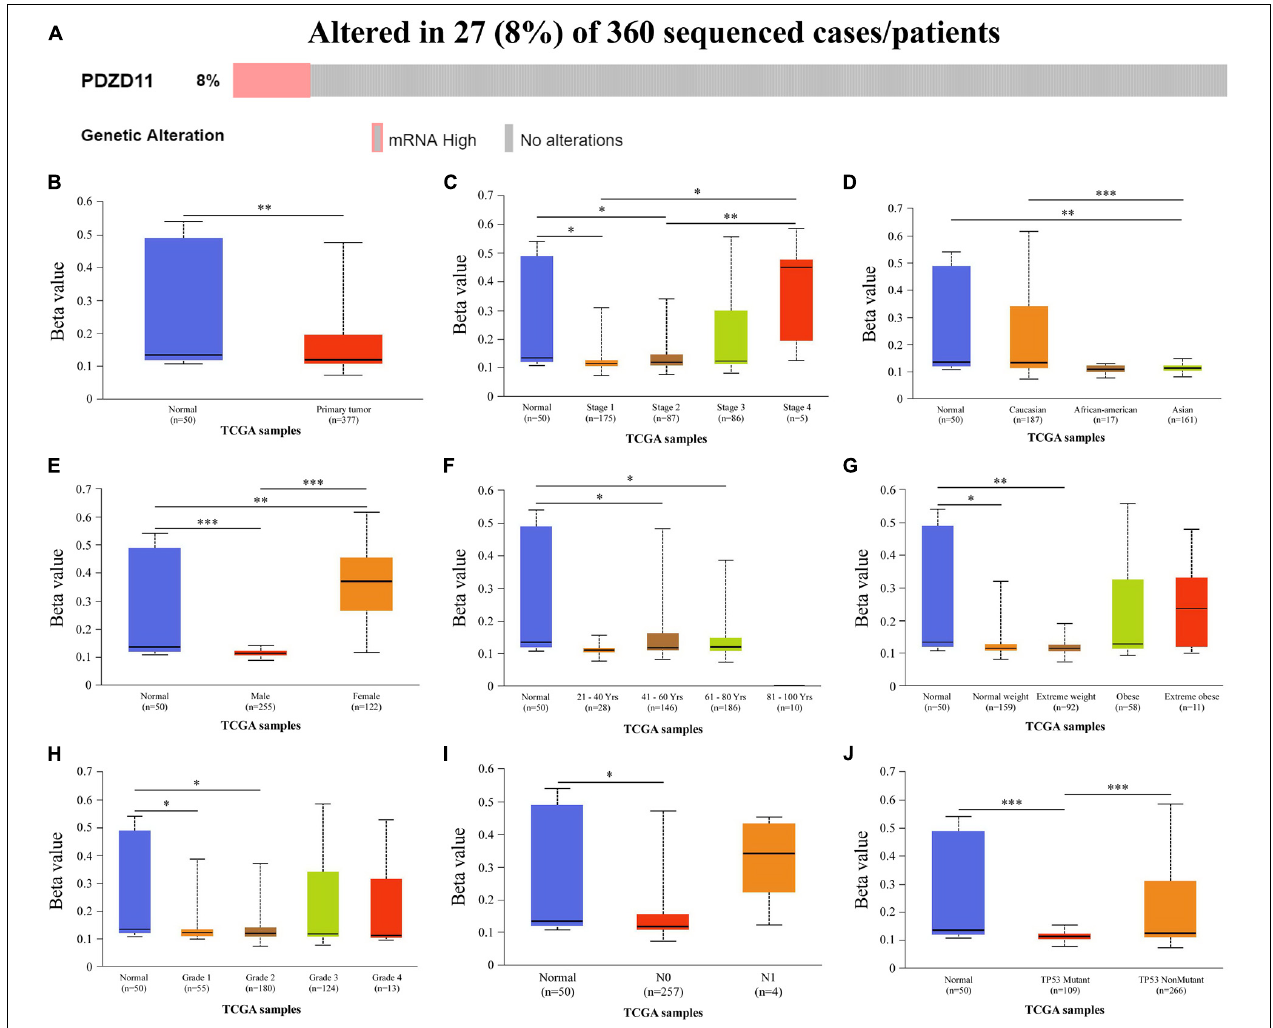
FIGURE 3 | Genetic alternations and promoter methylation levels of PDZD11 in LIHC. (A) Oncoprint in cBioPortal showed the distribution and proportion of samples with alternations in PDZD11 . (B) The promoter methylation levels of PDZD11 in LIHC. (C–J) Box plots show promoter methylation level of PDZD11 in normal vs. LIHC tissues and different individual cancer stages (C) , race (D) , gender (E) , age (F) , weight (G) , tumor grade (H) , nodal metastasis status (I) , and TP53 mutation status (J) (UALCAN database). Data are shown as mean ± SE. ∗ p < 0.05; ∗∗ p < 0.01; ∗∗∗ p <